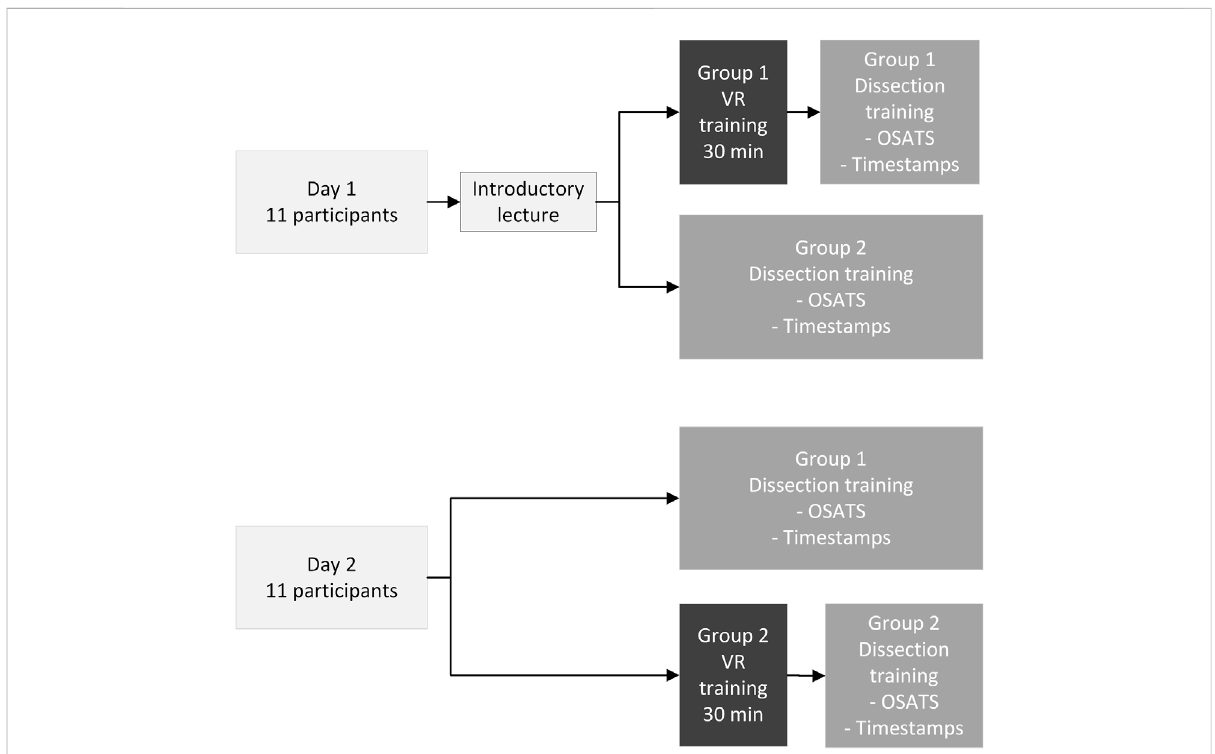
FIGURE 1 Flowchart.Group 1consisted of fi veand group2 sixparticipants,respectively. Every715participanthad individual temporal bonesfor eachday. The VRtraining was done fi rstand after 716that thesame temporal bonewasused during dissectiontraining.The dissectionperformances were717 assessed during andat theend ofthedissectionwith modi fi edOSATS. Surgical time (timestamps)718for theexposure ofanatomical landmarks was monitored. VR = virtual reality.